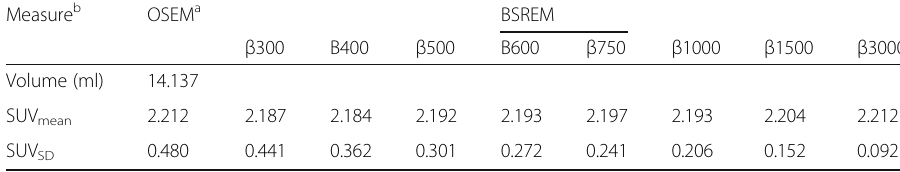
Table 3 Reference values measured in a healthy liver for OSEM and BSREM Measure b OSEM a BSREM β 300 Β 400 β 500 Β 600 β 750 β 1000 β 1500 β 3000 Volume (ml) 14.137 SUV mean 2.212 2.187 2.184 2.192 2.193 2.197 2.193 2.204 2.212 SUV SD 0.480 0.441 0.362 0.301 0.272 0.241 0.206 0.152